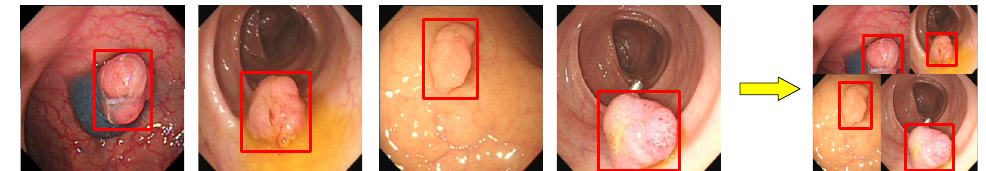
Figure 3. Mosaic data enhancement diagram. The red squares in the figure are the bounding boxes of the